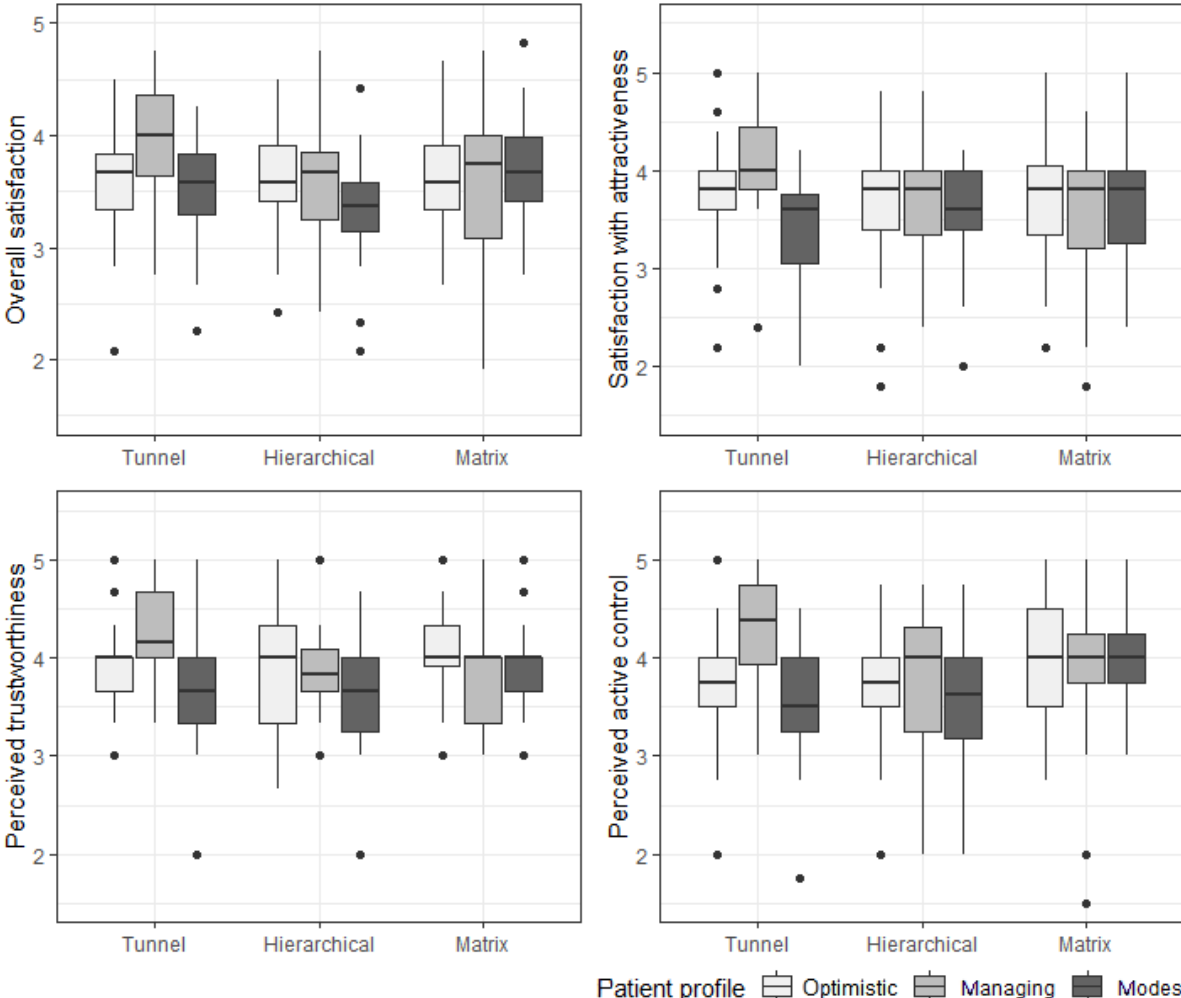
Figure 7. Interaction effects between information architecture and patient